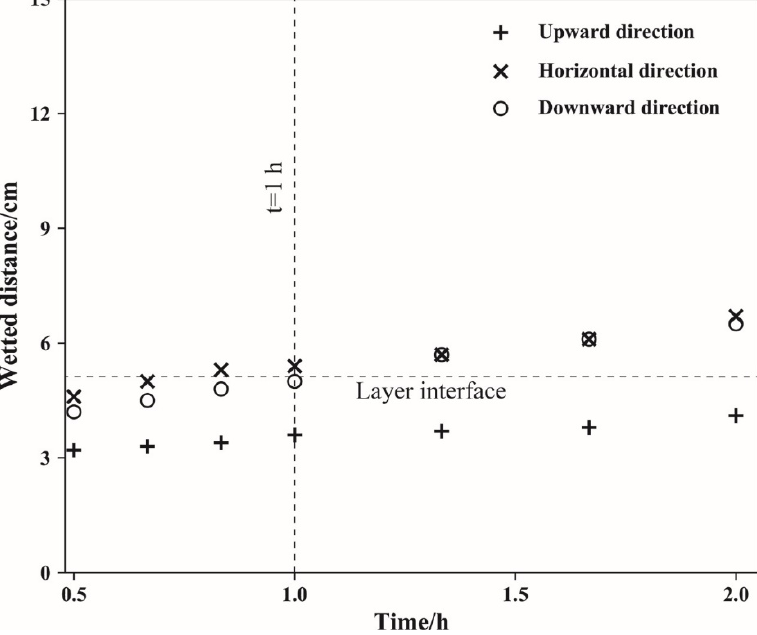
Figure 8. Evolution of wetting-front migration distance in layered soil.